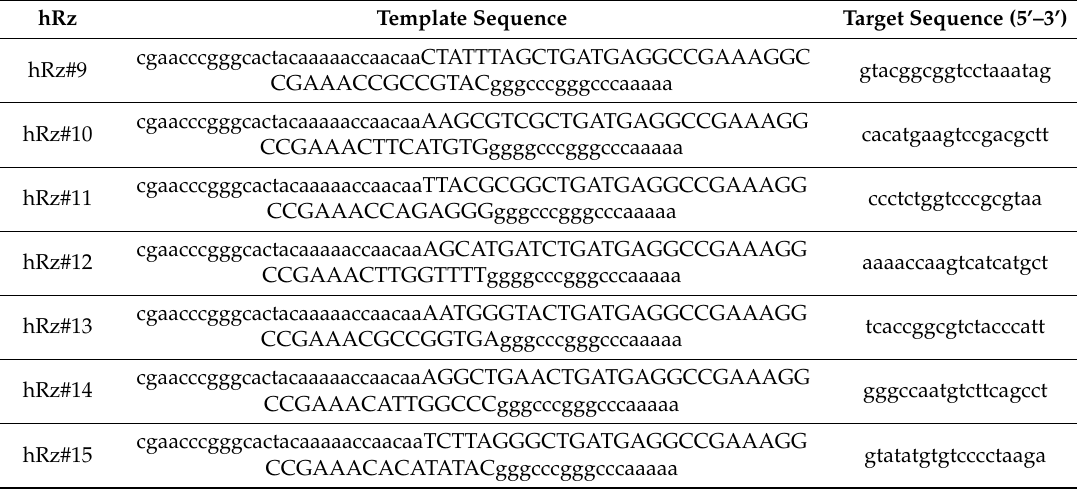
Table 1. Template sequences used to amplify the t-RNA val Pol III + hRz + PolyA (60) expression cassettes for each hRz, and corresponding CHIKV target sites. The hRzs’ sequence is indicated in uppercase. hRz Template